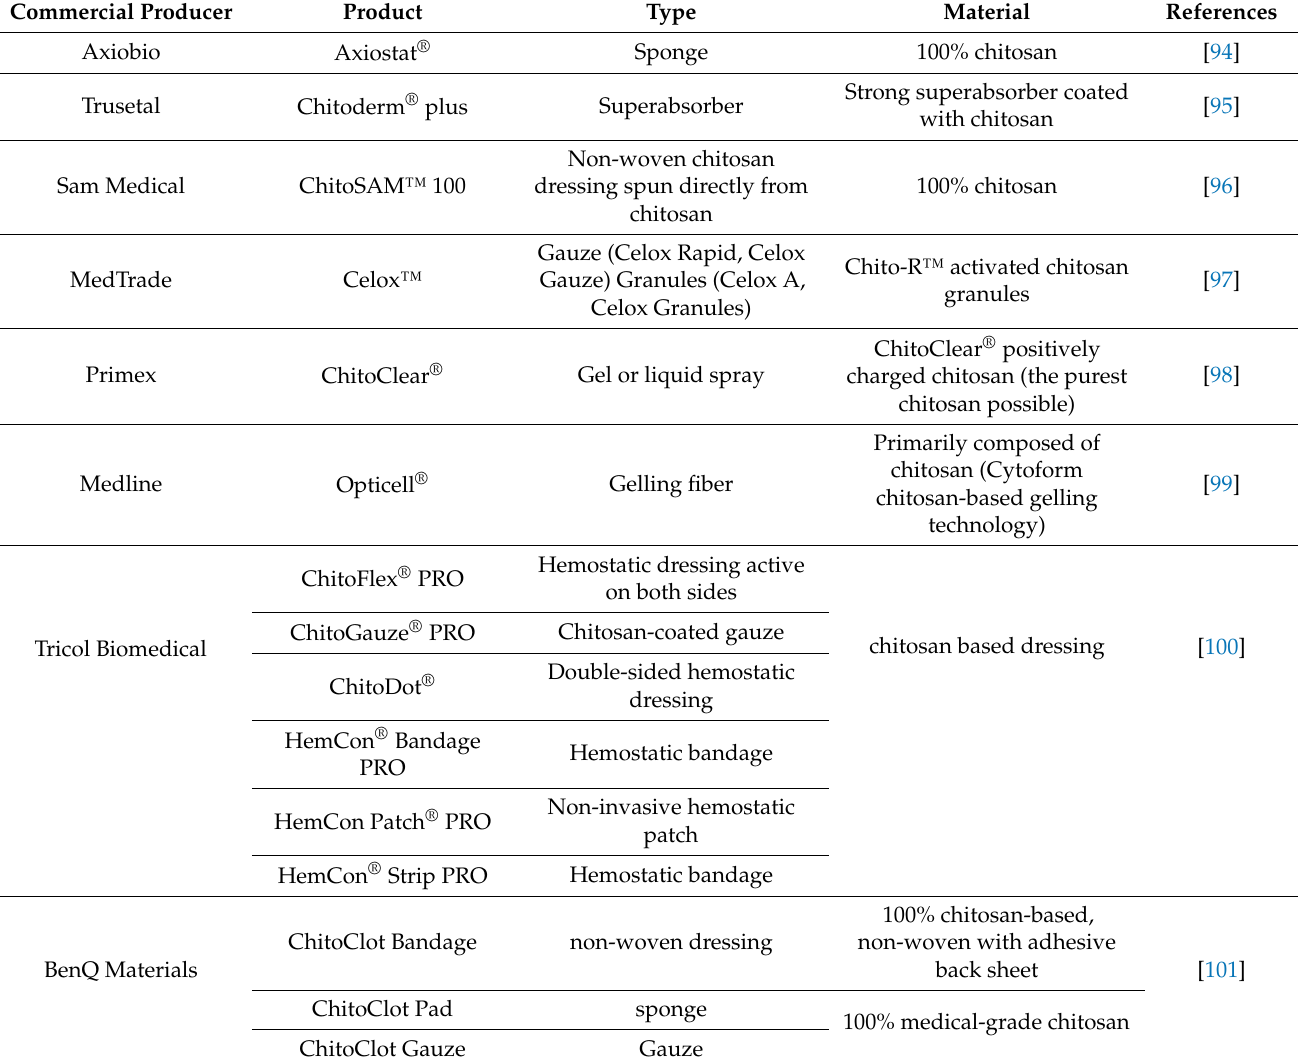
Table 1. Commercially available chitosan related wound dressing